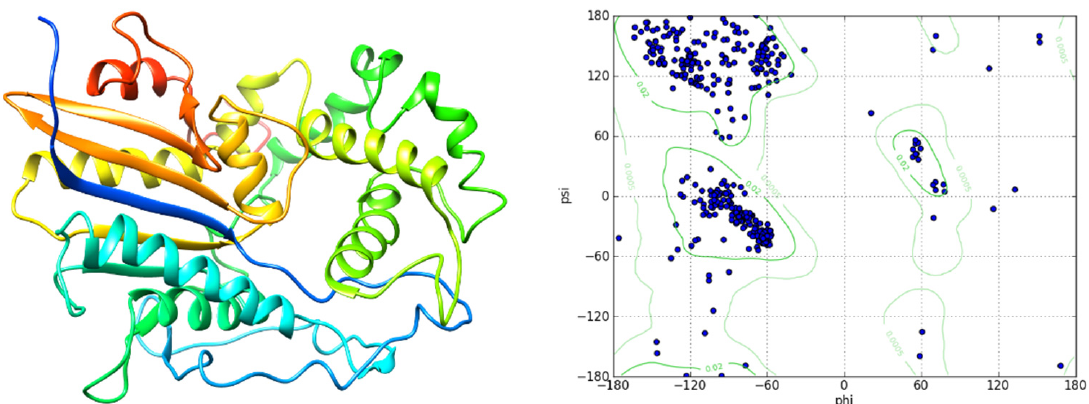
Figure 2. Predicted tertiary structure for Eh HAPp49. ( A ) Ribbon representation of the best model. Rainbow-colored from amino ( blue ) to carboxy ( red ). ( B ) Ramachandran plot.